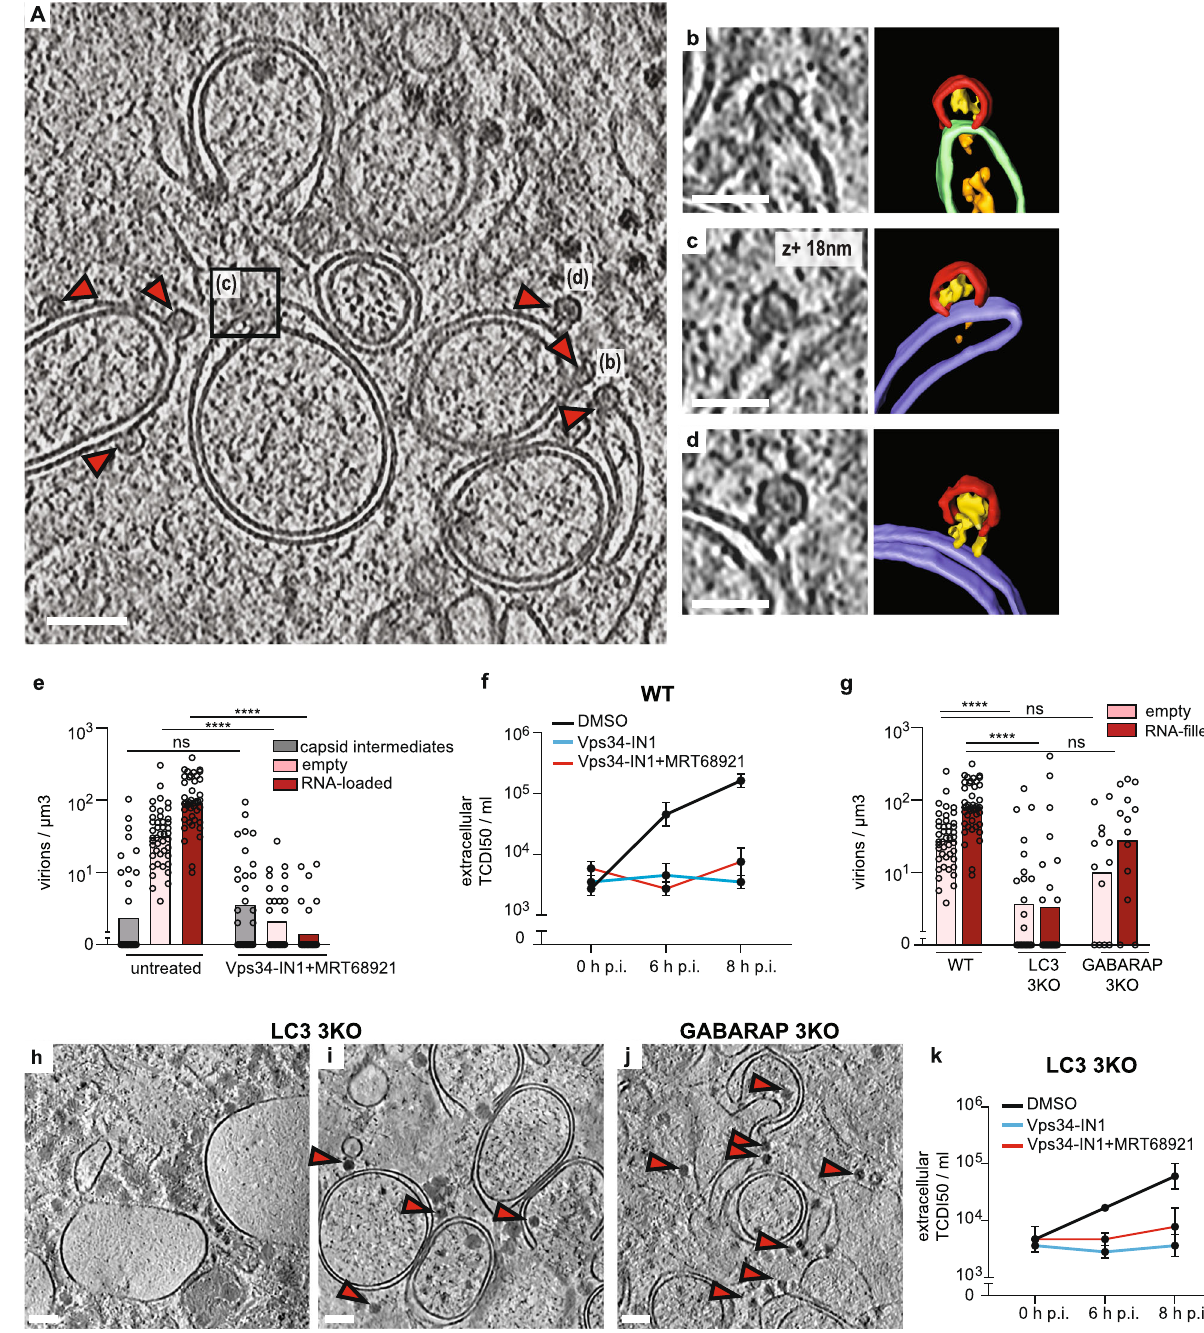
Fig. 3 | VPS34 inhibition stalls PV assembly at the half-capsid intermediate. a Cryo-electron tomogram of a PV-infected cell co-treated with Vps34-IN1 and MRT68921 at 6h p.i. b – d Magni fi ed views of capsid intermediates indicated in ( a ), and their corresponding segmentations. Capsid intermediates (red), intra-capsid densities (yellow), ALM (purple), SM (green), luminal densities (orange). d The magni fi ed view shows a near-complete capsid tethered to a double-membrane vesicle. e Concentration of intracellular capsid intermediates, empty capsids and RNA-loaded virions as observed in ( n ) tomograms of untreated ( n =51) and Vps34- IN1+MRT68921 ( n =32) treated cells at 6h p.i., bars represent the averages (see also Supplementary Table 2). Statistical signi fi cance by unpaired two-tailed Stu- dent ’ s t test; **** p <0.0001. f Released virus titer at 0, 6, and 8h p.i. in WT cells treated with DMSO, Vps34-IN1, and Vps34-IN1+MRT68921. Bars represent the